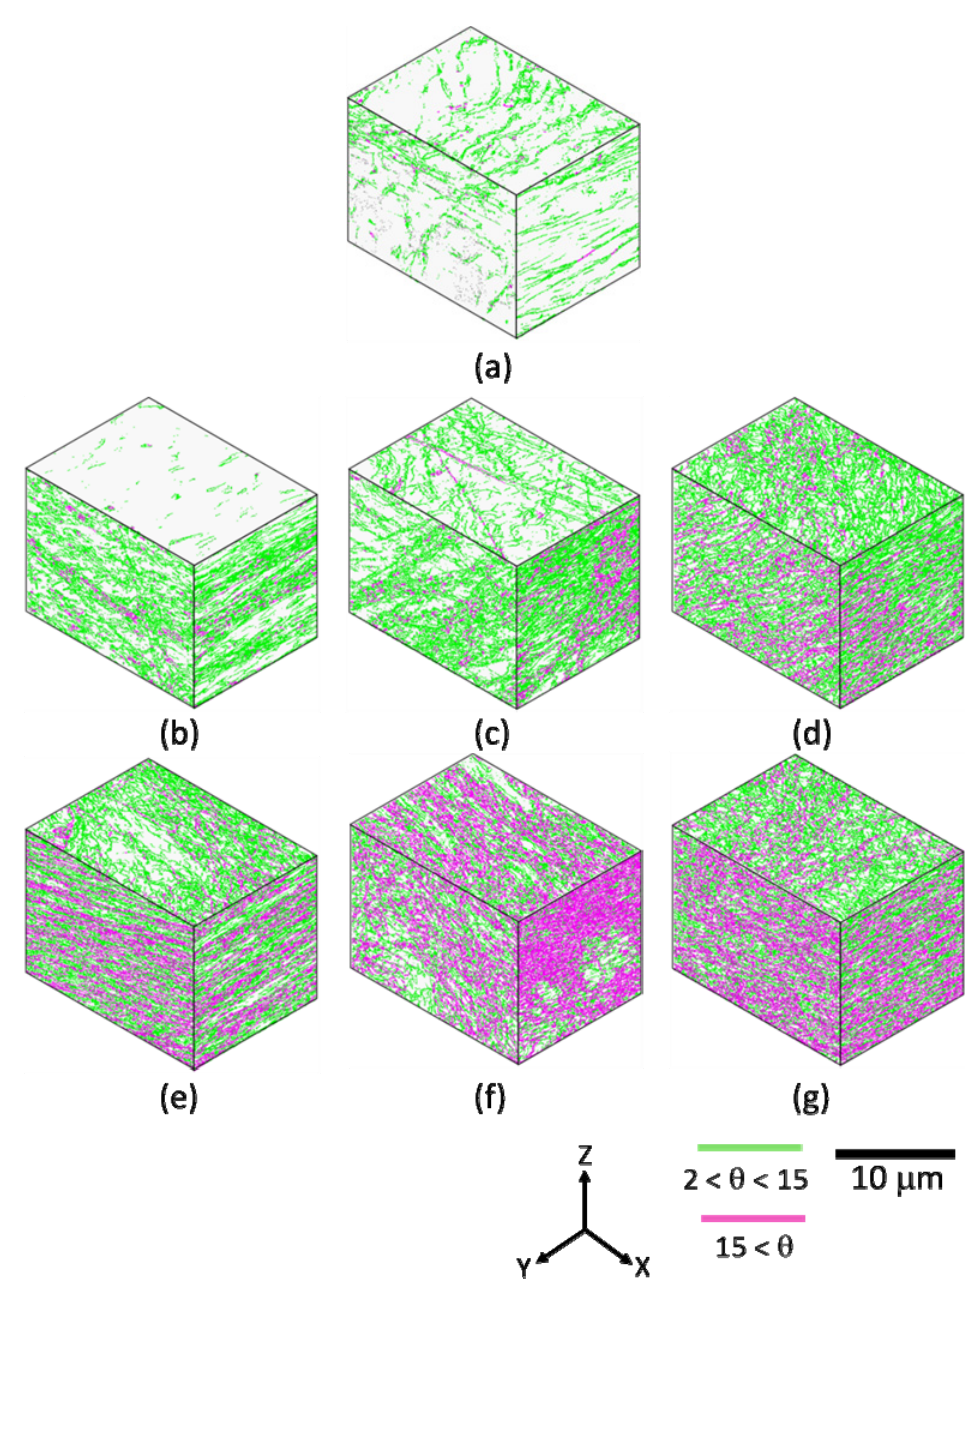
Figure 2. 3D Misorientation map of low CN Fe-20%Cr alloy after ECAP ( a ) one pass; ( b ) two passes route A; ( c ) two passes route Bc; ( d ) two passes route C; ( e ) four passes route A; ( f ) four passes route Bc; ( g ) four passes route